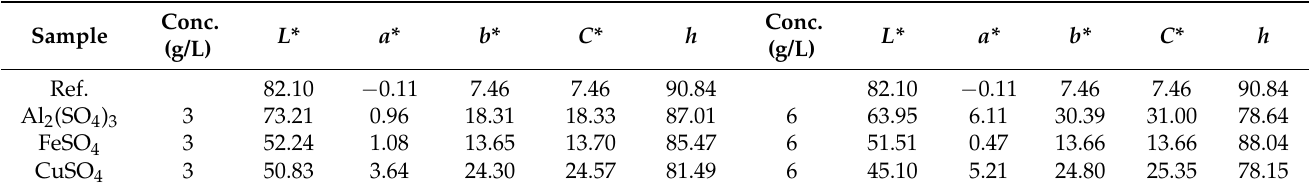
Figure 2. Colorimetric evaluation of un-dyed (ref.) and dyed wool fibers using different mordants: ( a ) Reflectance values and photographs of dyed samples; ( b ) K/S values; lower mordant concentra- tion ( above ) and higher mordant concentration ( below ). Table 1. CIE color values of reference (ref.) and dyed samples using different concentrations (Conc.) and types of